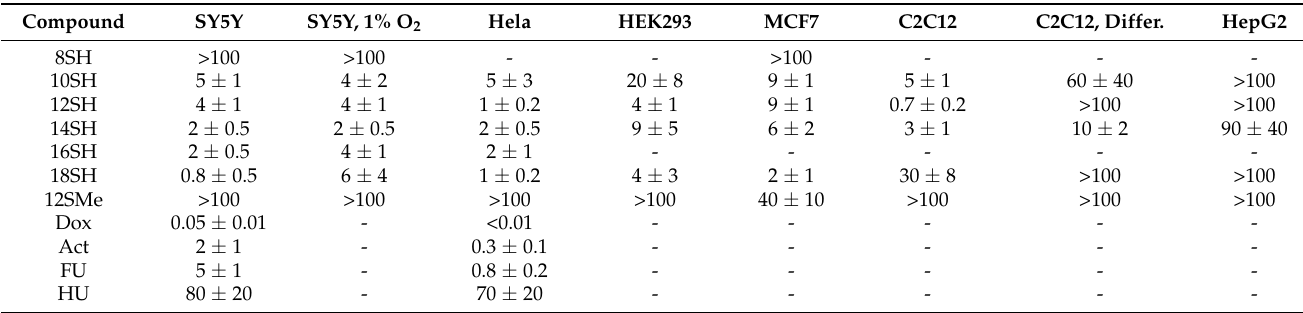
Figure 1. Inhibitory effect of different thiol-type chain-transfer agents on cellular proliferation in SY5Y cells, Hela cells, HEK293 cells and MCF7 cells. Compound abbreviations are explained in Table 1. Cellular proliferation was assessed by metabolic MTT assay as described in the Materials and Methods. The control line at 100% represents the metabolic activity of the adherent cells at the beginning of the experiment; the variable, upper control line represents the final activity of the cells after the 3-day experiment. Note that MCF7 cells exhibited a much lower cell division rate than the other cells, amounting to less than one population doubling over the course of the experiment. Table 2. Half-maximal effective concentrations ( µ M) of the chain-transfer agents and the control compounds investigated in this